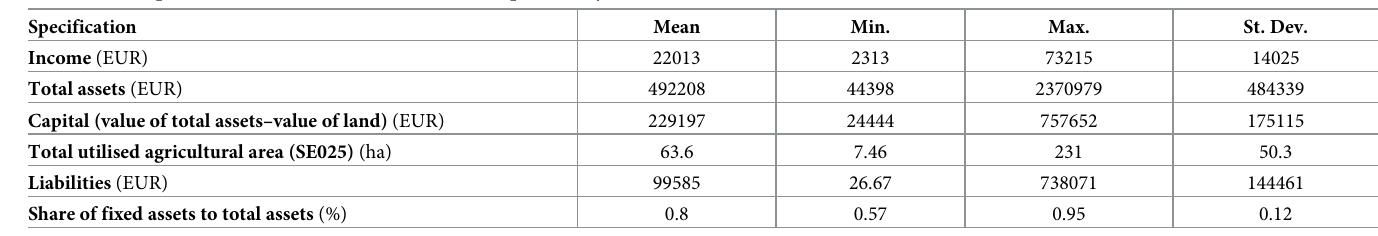
Table 2. Descriptive statistics for the variables used in the panel analyses (2004–2018).